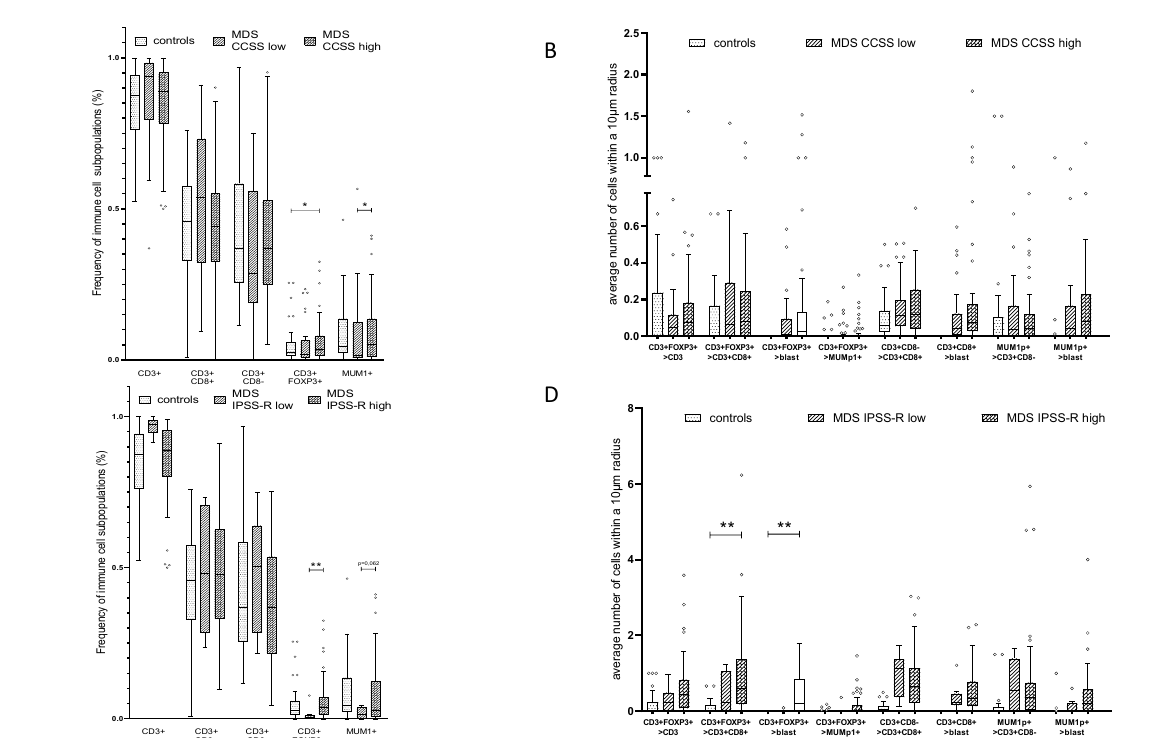
Figure 4. Composition and frequency of the immune cell infiltrate and their spatial distribution to CD34 + blasts in MDS/sAML in association to the karyotype and the IPSS-R. ( A ) Correlation of MDS with CCSS low and high to the frequency of MUM1p+CD3 − post–germinal center B cells/plasma cells, CD3+CD8+, CD3+CD8 − , and CD3+FOXP3+ T cells, presented as number of immune cell subpopulations in % with a significant correlation of MUM1p+CD3 − post–germinal center B cells/plasma cell frequency/CD3+FOXP3+ T cells and CCSS high. ( B ) Correlation of CCSS high versus CCSS low MDS specimen considering the average number of immune cell subpopulations within a radius of 10 µ m around CD34+ blasts revealed no significant differences between the CCSS high versus CCSS low prognostic group. ( C ) Correlation of MDS with IPSS-R risk score low and high to the frequency of MUM1p+CD3 − post-germinal center B cells/plasma cells, CD3+CD8+, CD3+CD8 − , and CD3+FOXP3+ T cells, presented as number of immune cell subpopulations in % with a significant correlation of CD3+FOXP3+ T cells and slightly increased numbers of MUM1p+CD3 − B/plasma cells in IPSS-R high risk cases. ( D ) Spatial analysis data for IPSS-R high versus IPSS-R low in untreated MDS specimen considering average number of immune cell subpopulations within a radius of 10 µ m revealed no significant differences. Statistically significant relations are marked with asterisks (* p < 0.05; ** p <0.005, *** p < 0.0005, **** p <